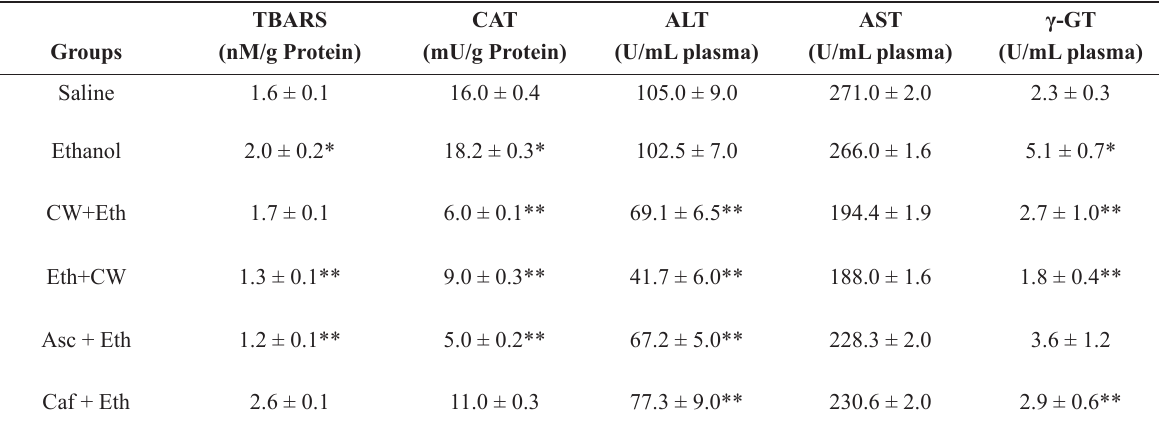
Concentration of TBARS and catalase activity in liver and ALT, AST, γ-GT in serum of rats treated by ethanol. TBARS Groups